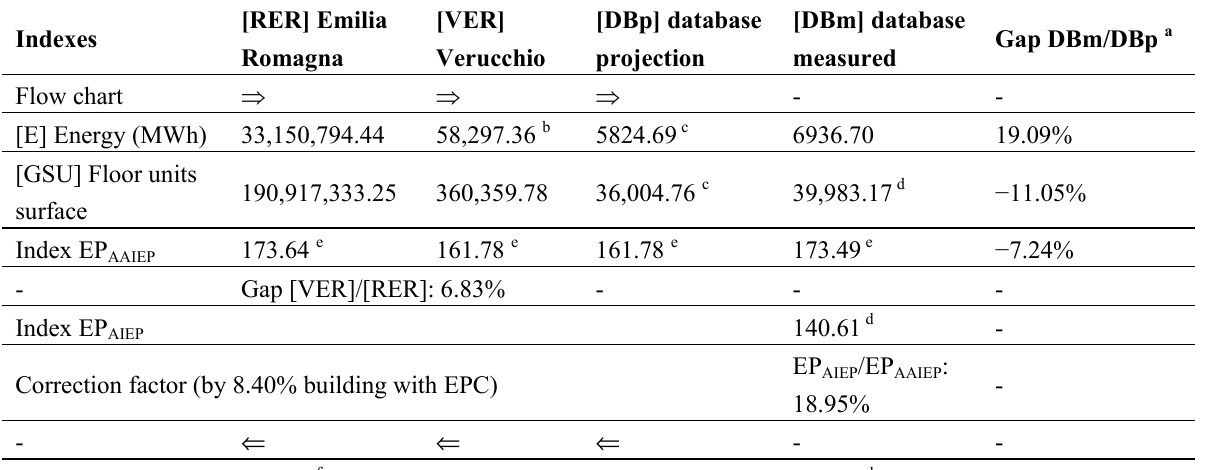
Table 17. Database 2011: top-down to bottom-up